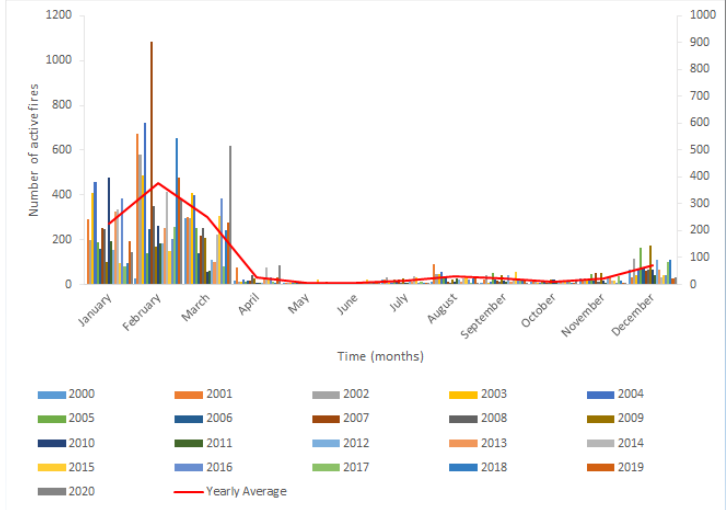
Figure 5. Temporal distribution of active fires in Colombia, by month, from 2000 to 2020.